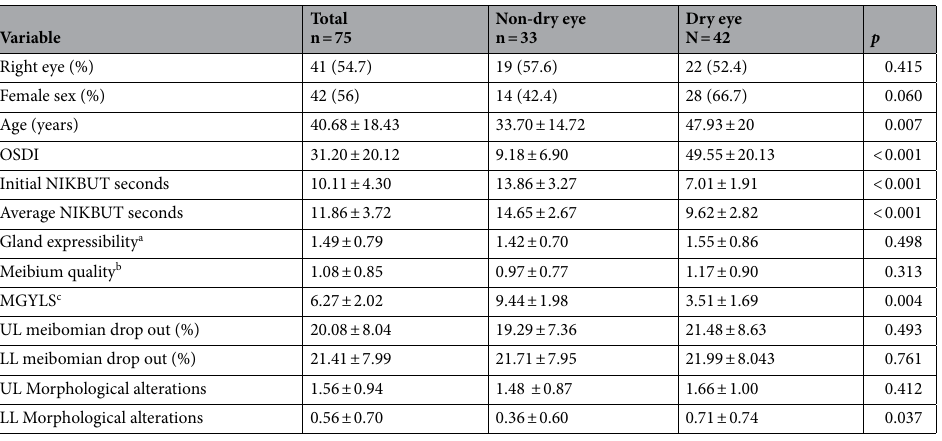
Table 1. Demographic and general characteristics. non-invasive tear film break- up time (NIKBUT), Ocular Surface Disease Index questionnaire (OSDI), Upper lid (UL), Lower lid (LL). a The classification used to evaluate gland expressibility was 0 = all glands expressible, 1 = 3–4 glands expressible, 2 = 1–2 glands expressible, 3 = no glands expressible according with Daniel et al. DREAM study 10 . b The classification proposed by Bron et al. 33 was used to evaluate the meibum quality as follows: clear (0), opaque (1), opaque with detritus (2), and toothpaste (3). Only the highest grade found among the expressed glands was recorded. UL = Upper eyelid, LL = Lower eyelid. c MGYLS = meibomian glands yielding liquid secretion score of the whole lid was determined according to Korb et al. 32